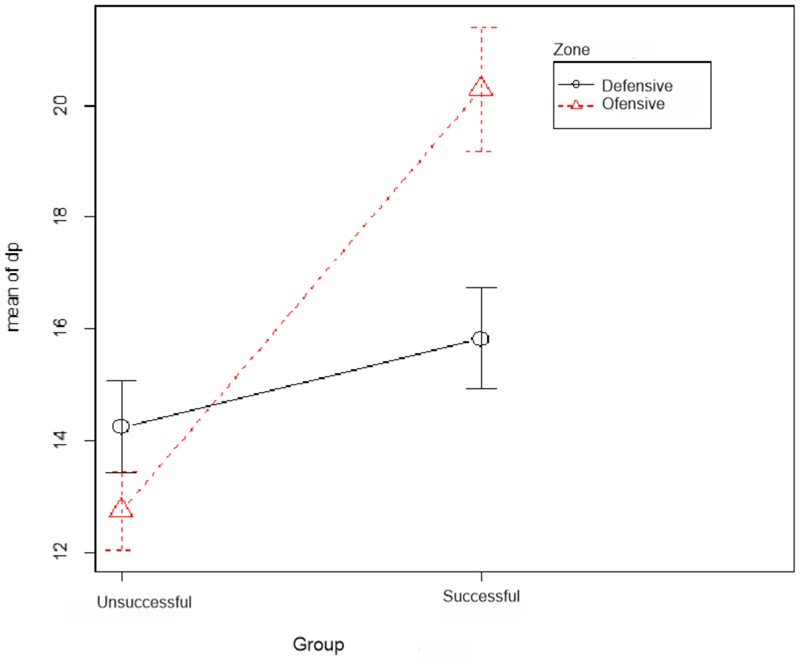
Mean comparison.